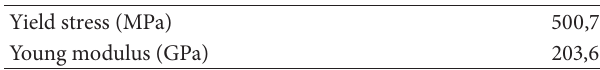
Table 3: Material characteristics of steel reinforcement.